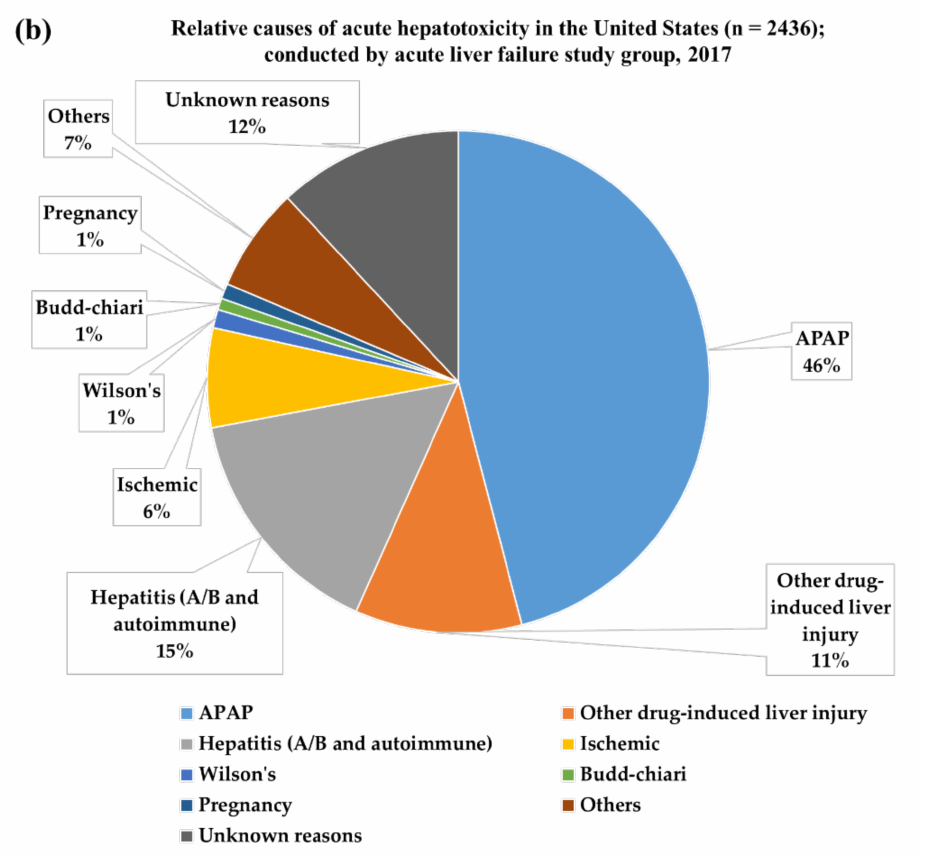
Figure 1. Relative frequency of acute hepatotoxicity caused by different factors in the United States. ( a ) In the United States, between 1994 and 1996, there was a 20% incidence ( n = 295) of acute APAP poisoning leading to acute liver failure [34]. ( b ) The incidence of acute APAP hepatotoxicity was increased to 42% ( n = 2436) in 2017